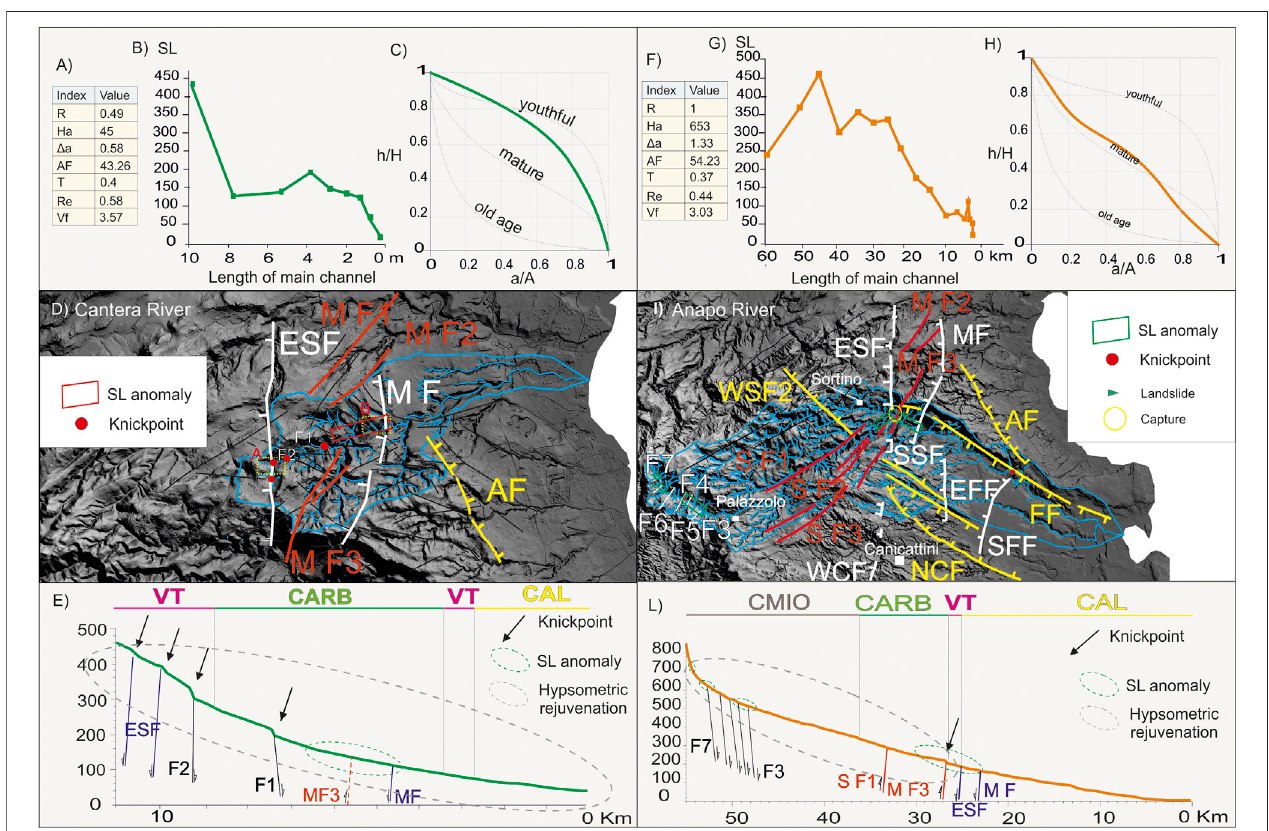
FIGURE 11 | From (A – E) : Cantera River analysis. From (F – L) : Anapo River analysis. (A,F) Hierarchical parameters (R, Ha and Δ a) and geomorphic indexes (AF, T average, Re and Vf average). (B,G) SL index graph. (C,H) Hypsometric curve. (D,I) River and faults crossing the area; in (D) the rectangles labeled A and B refer to the location of Figures 12D,E , respectively. (E,L) Long stream-pro fi le and litho-types on which the main channel fl ows (colored bar, see Figure 2 for the key).